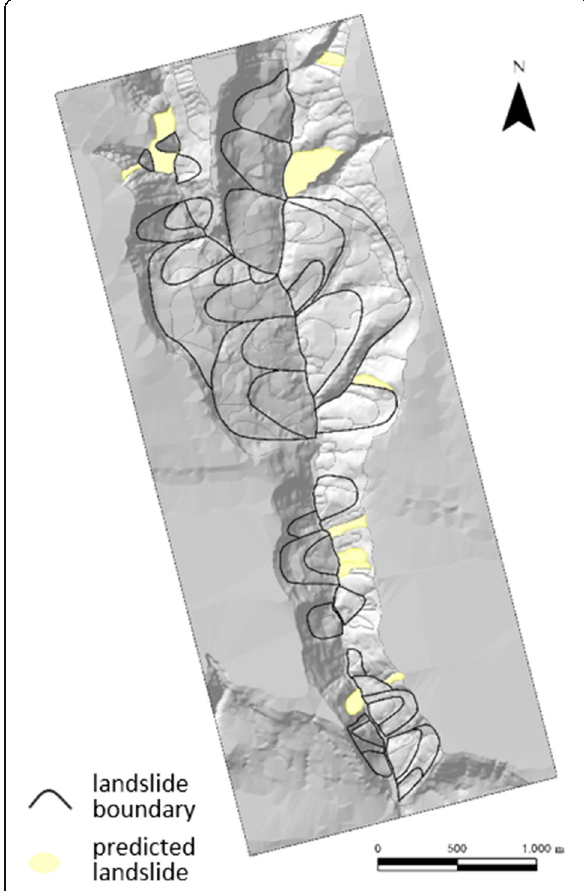
Fig. 19 Map with predicted landslide susceptibility (slopes potential to landslides in yellow